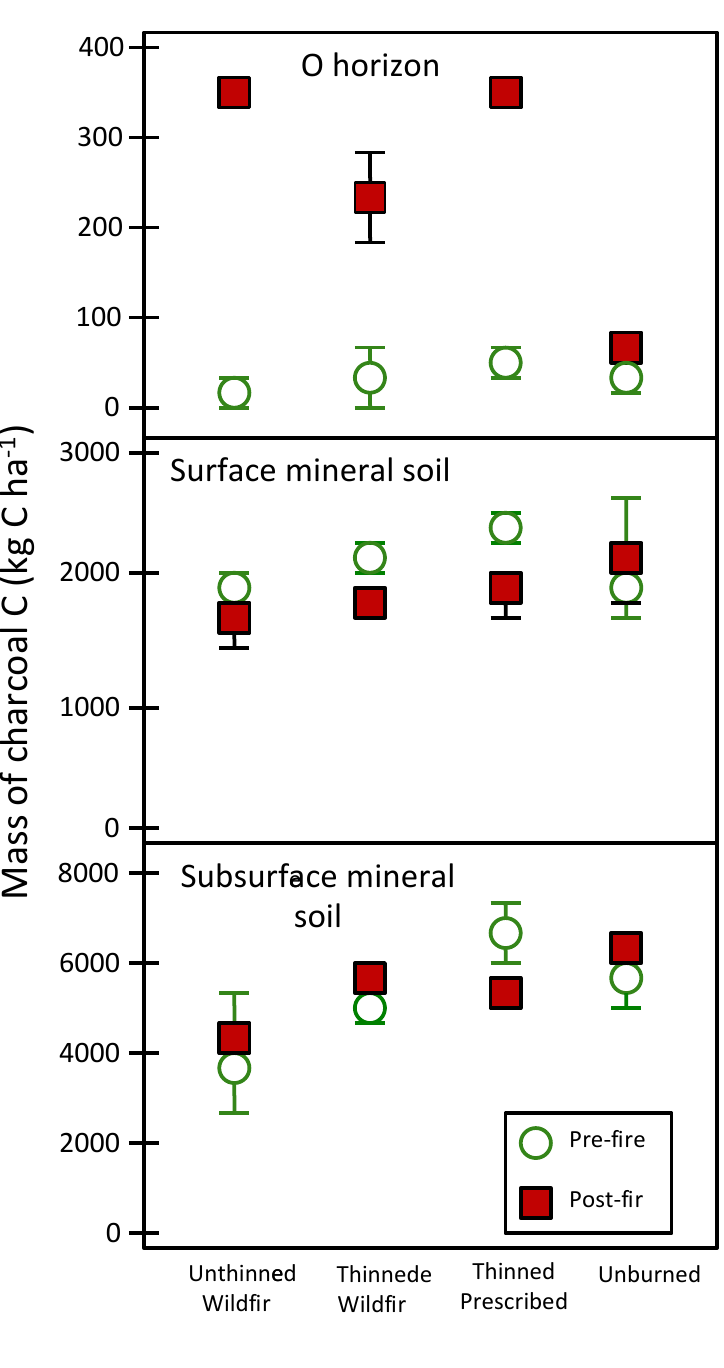
Figure 1. Pre and post-fire charcoal C by treatment: unthinned wildfire, thinned wildfire, thinned prescribed fire, unburned. O horizon 0.5 − 20 mm charcoal fraction. Mineral soil layers < 4 mm charcoal fraction. Mean ± standard error, n =